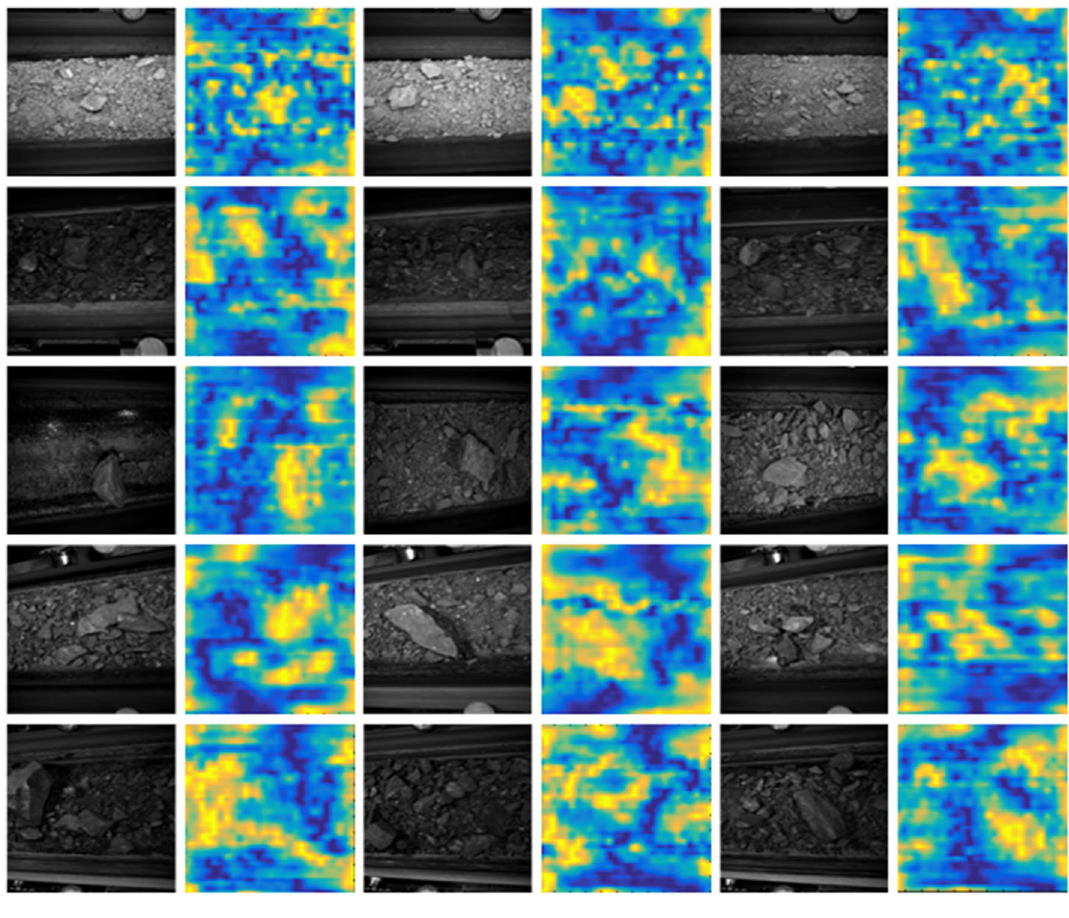
Figure 9. Example of attention